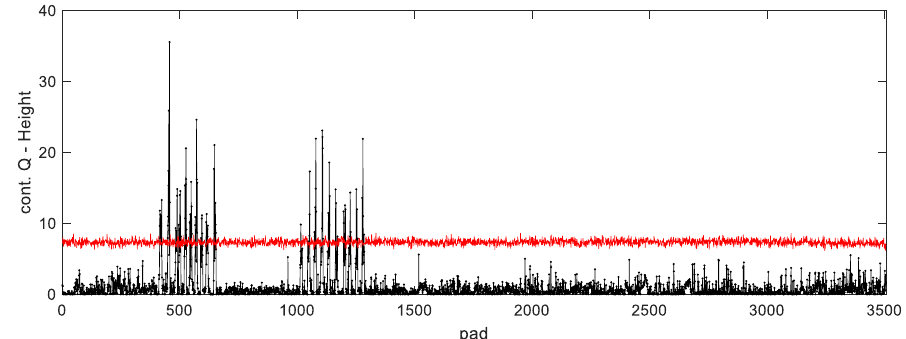
Figure 19. Contribution of the pads’ height to the Q -statistic of PCB #248 of CS3.